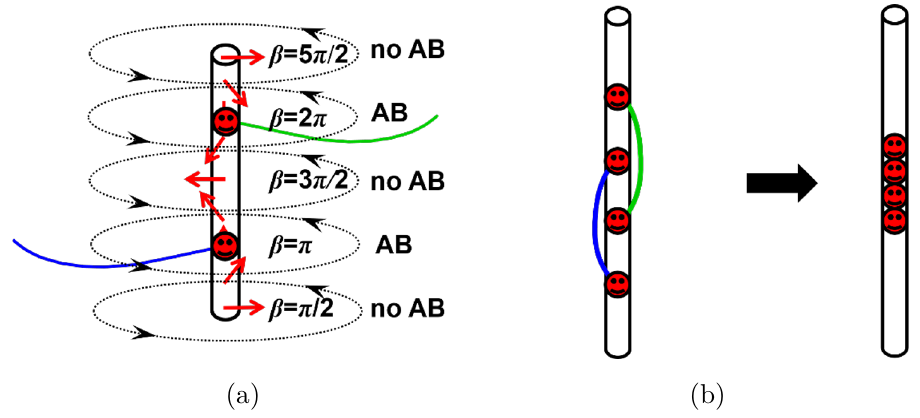
Figure 8 . Monopoles on a string in the confined phase. (a) a single monopole on a string is split into two half monopoles, each of which is attached by a different AB defect. (b) two monopoles or four half monopoles on a string connected by the two different AB defects (left), and a monopole meson on a string